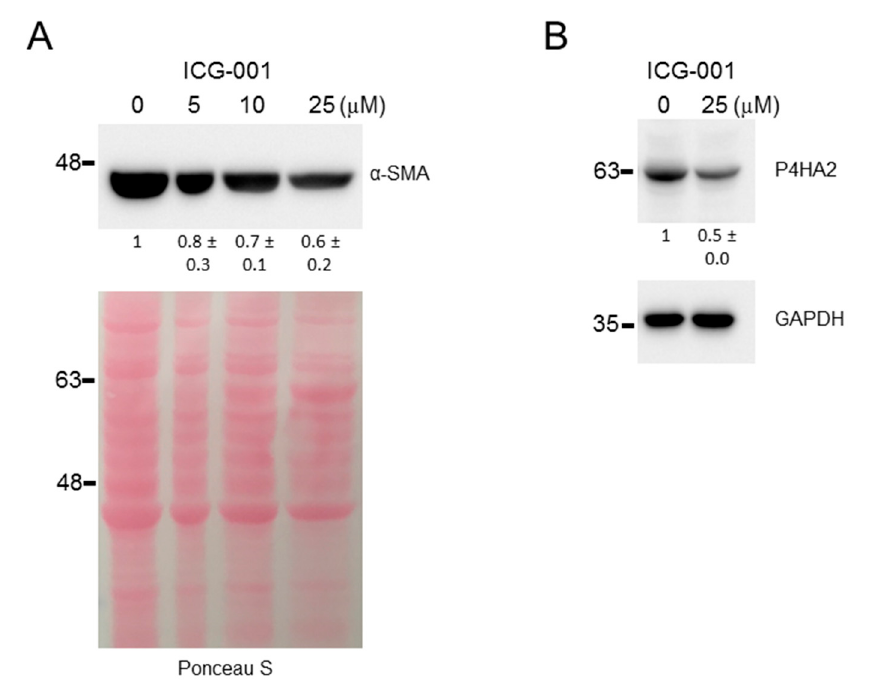
Figure 4. CBP/ β -catenin antagonism suppresses protein expression of activation markers of pancreatic stellate cells as assessed by immunoblot. Effect of CBP/ β -catenin antagonist ICG-001 versus control (DMSO) treatment for 72 h of immortalized mouse pancreatic stellate cells (imPSC) on protein expression of activation markers, Acta2 ( α -SMA) ( A ) and Prolyl 4-hydroxylase (P4HA2) ( B ). Numerical values below protein bands indicate densitometric quantitation normalized to Ponceau S or GAPDH as indicated and then to control (DMSO). Numerical values and associated horizontal marks to the left of protein bands indicate relative position of molecular weight (kDa) markers. (Whole immunoblots are presented in Figure S1.).